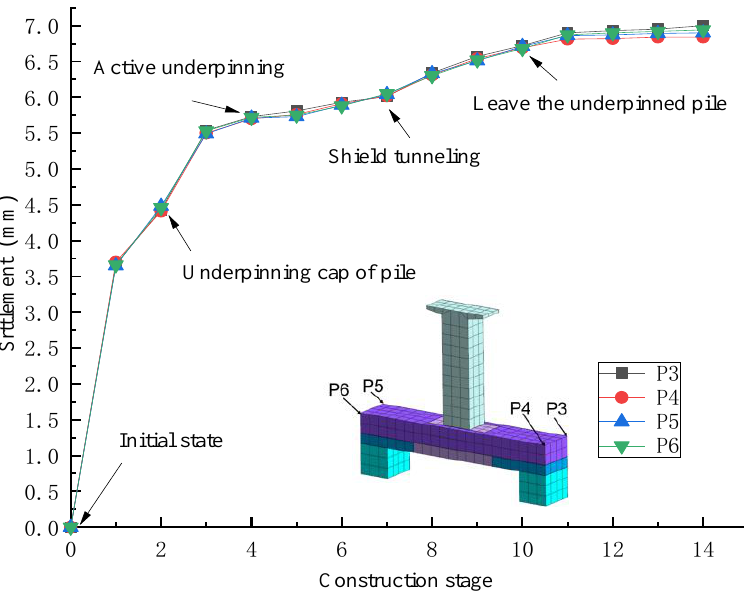
Figure 9. Vertical displacement of the underpinning pile cap.